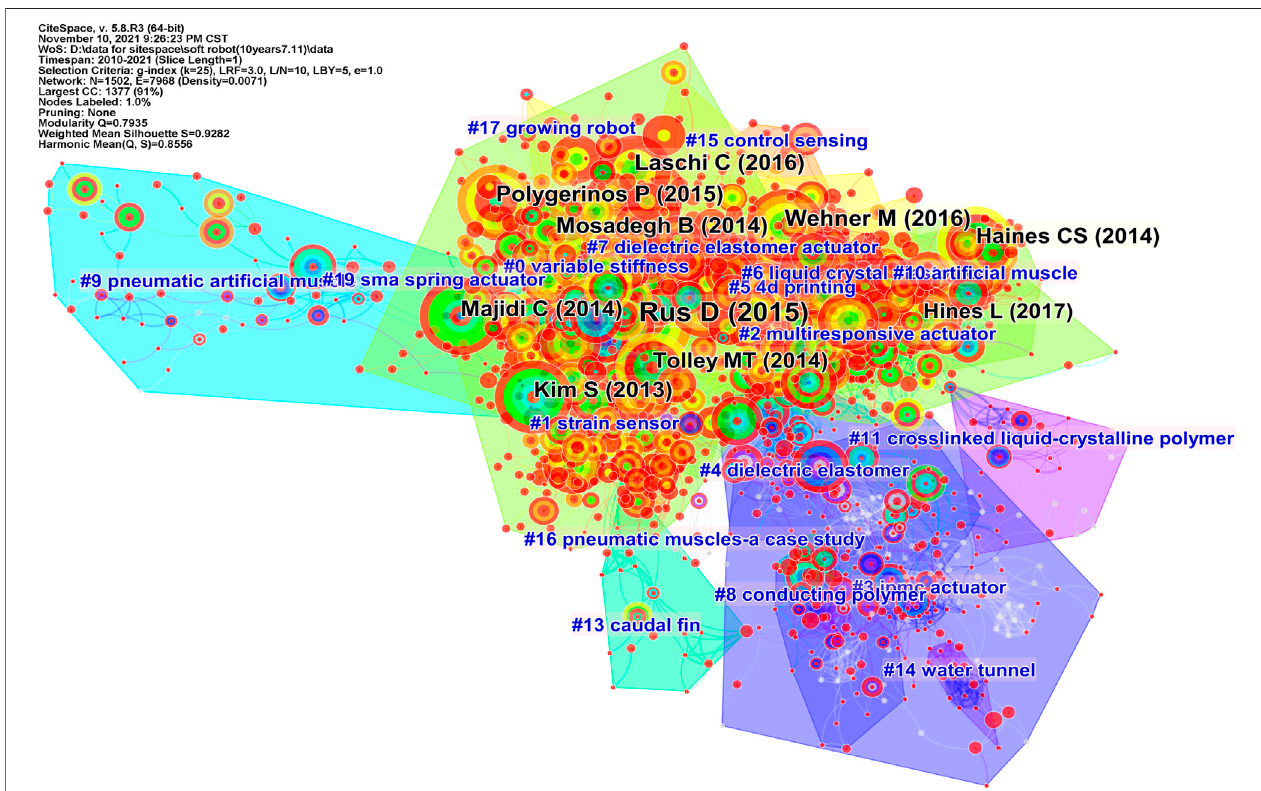
FIGURE 4 | Trajectories of relevant research shown in a network of co-cited references and clustering from titles, where clusters are labeled in blue text and landmark articles in black.